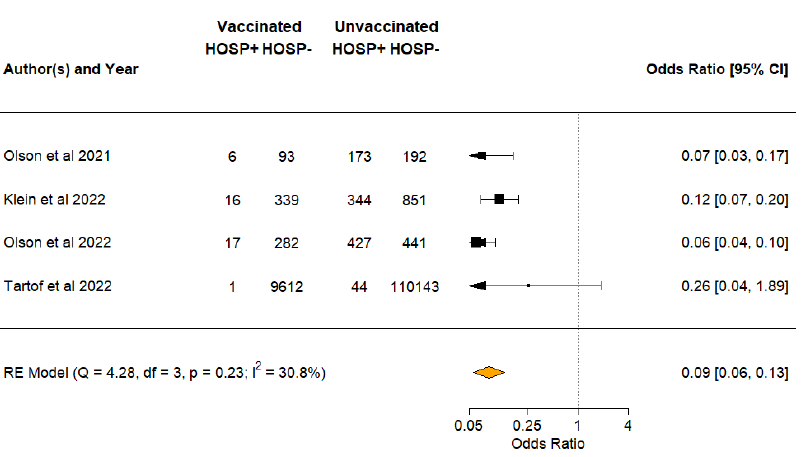
Figure 4. Vaccine effectiveness against admission into ICU [35,36]. The black square symbol pre- sented for each study represents its point estimate, and the size is proportional to the weight of the study in relation to the pooled estimate. The red diamond symbol represents the overall effect esti- mate from the meta-analysis. 3.5. Vaccine Effectiveness by Time from Immunisation or Vaccination Seven studies reported the impact of time from immunisation after second dose on the effectiveness of Pfizer-BioNTech [24,25,27,30,31,33,36]. VE was investigated for the Delta strain of the virus in all the studies [24,25,27,30,31,33,36], while only two studies reported VE against the Omicron variant [26,31]. The VE from the studies were pooled and the average VE reported for each week is presented in Table 2. The vaccine was more effective against the Delta variant, with a VE of approximately 91% from 1 week to 12 weeks after vaccination. In contrast, VE against the Omicron variant was 44% within 2 to